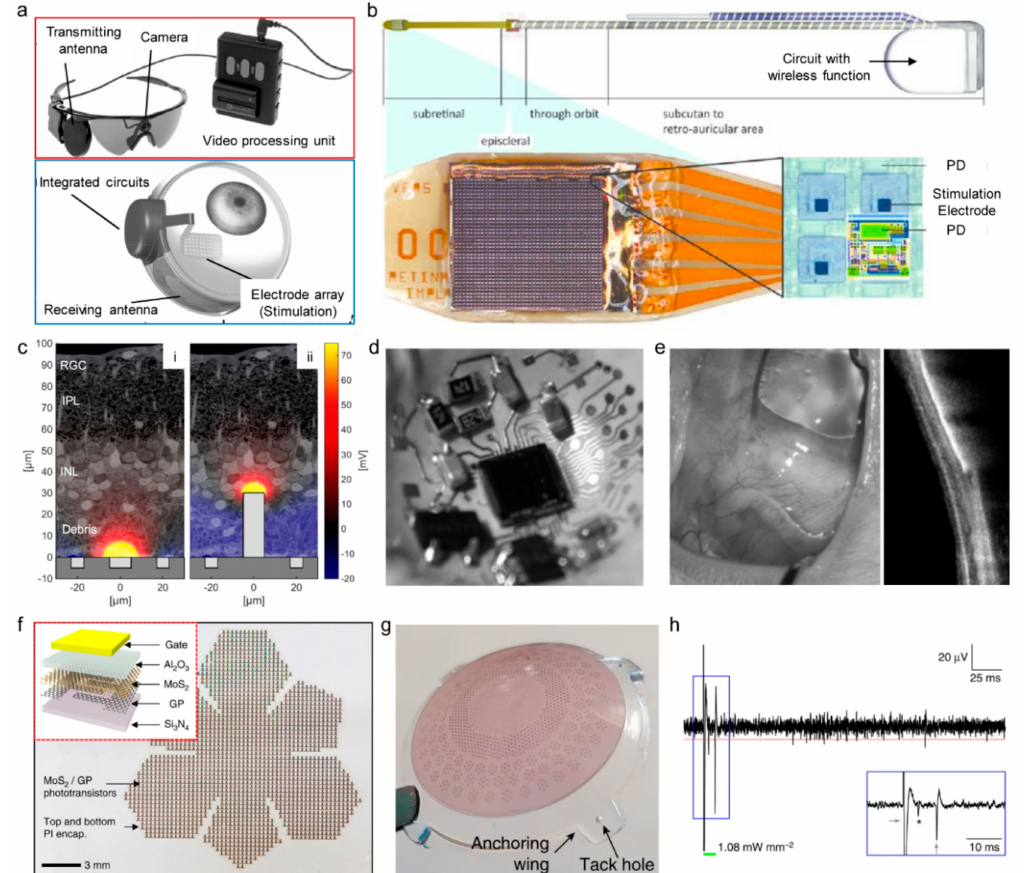
Figure 9. Retinal prostheses. ( a ) Schematic illustration of a neural prosthesis system with an external camera and internal electrode arrays (Argus II System) (Reproduced under the terms of CC BY-NC-ND license [150]. Copyright 2016, American Academy of Ophthalmology). ( b ) Schematic illustration of